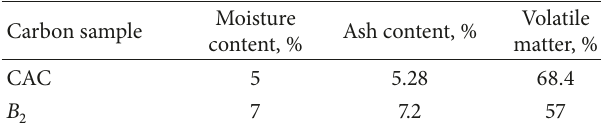
Table 8: Physicochemical properties of the synthesized and com- mercial activated